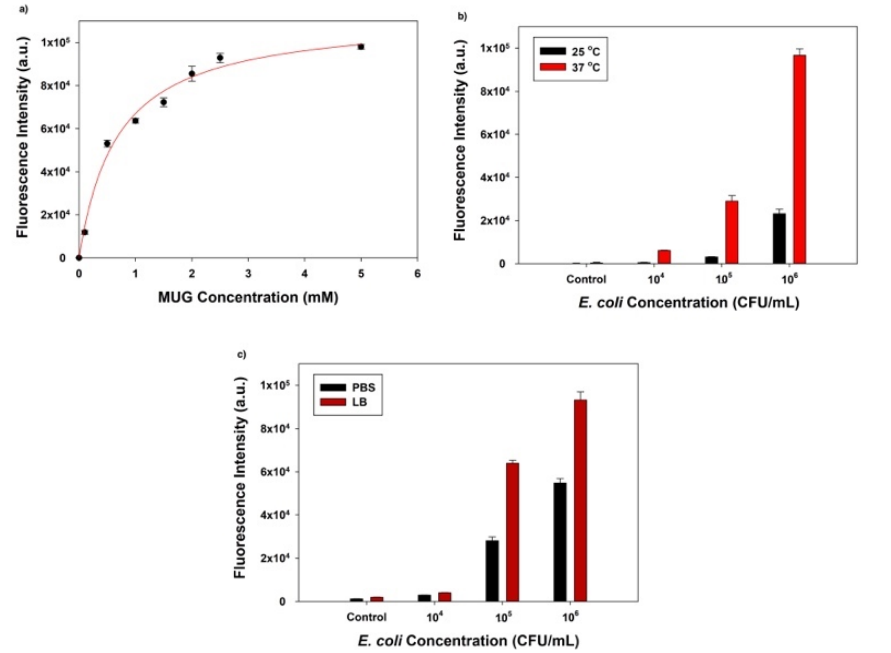
Figure 2. ( a ) The determination of optimal MUG concentration based on fluorescent intensities; ( b ) comparison of the fluorescence intensity obtained at two incubation temperatures (37 ◦ C, red bars; 25 ◦ C, black bars); ( c ) comparison of the fluorescence intensity obtained using two reaction media: phosphate-buffered saline (PBS) (black bars) and Luria–Bertani (LB) broth (red bars). The control group indicates the absence of bacteria in the reaction mixture. The values reflect the average of at least three independent biological replicates and standard deviation is shown as the error bars in each graph.